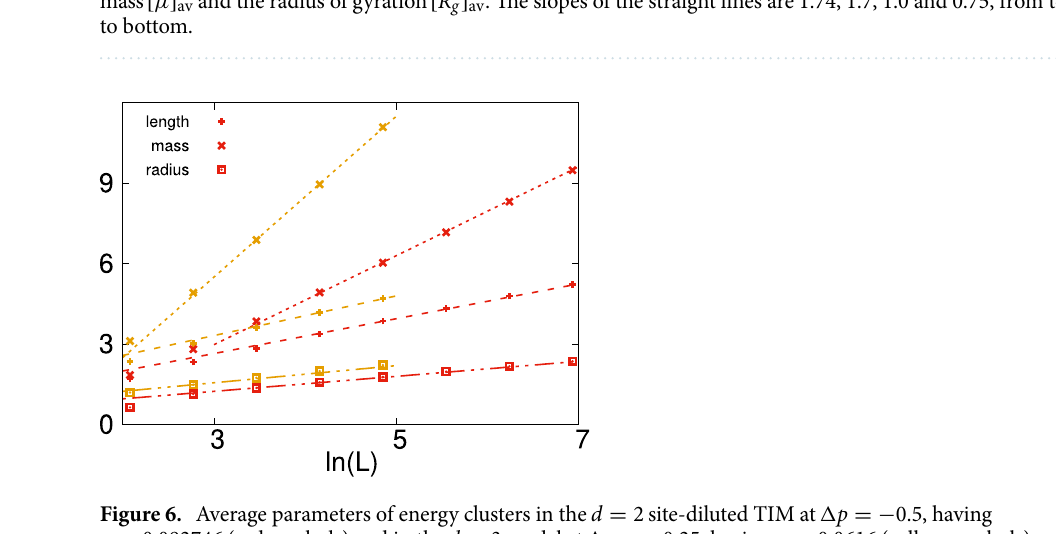
Figure 6. Average parameters of energy clusters in the d = 2 site-diluted TIM at (cid:31) p = − 0.5 , having p = 0.092746 (red symbols) and in the d = 3 model at (cid:31) p = − 0.25 , having p = 0.0616 (yellow symbols) as a function of the logarithm of the size of the system: the linear extension [ ℓ ] av with asymptotic slopes (cid:31) ≈ 1.66 ( d = 2 ) and (cid:31) ≈ 3. ( d = 3 ); the mass [ µ ] av with asymptotic slopes σ ≈ 0.65 ( d = 2 ) and σ ≈ 0.74 ( d = 3 ) and the radius of gyration [ R g ] av with asymptotic slopes ρ ≈ 0.28 ( d = 2 ) and ρ ≈ 0.32 ( d = 3